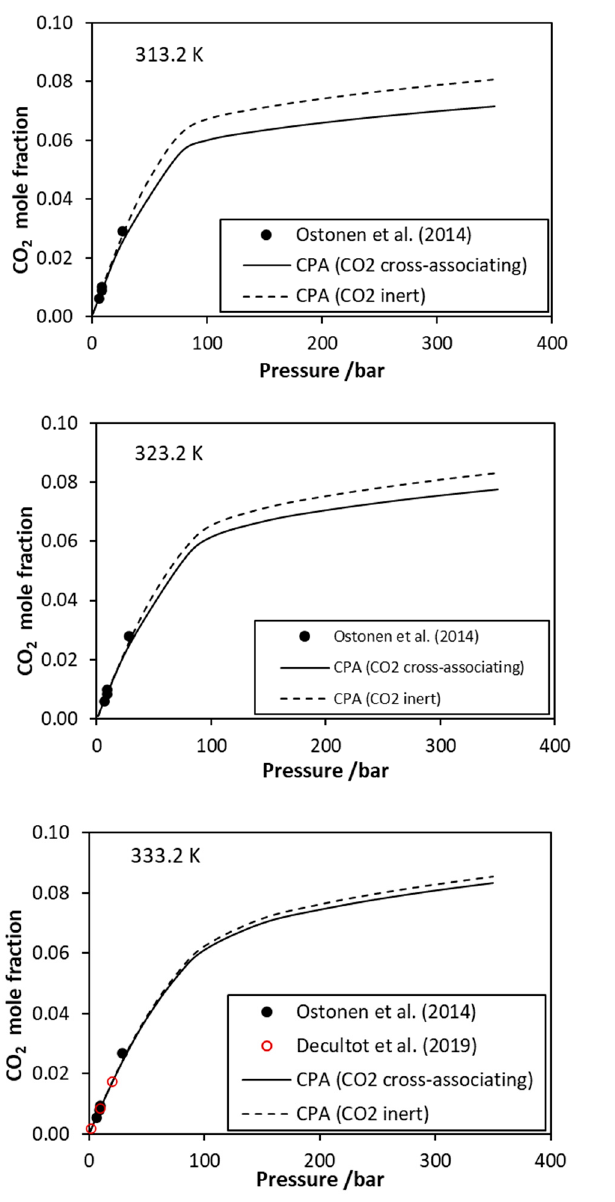
Figure 3. CO 2 –glycerol VLE. CO 2 mole fraction in the liquid phase and glycerol mole fraction in the vapor phase. Experimental data [39–42] and CPA correlations using the interaction parameters of Table 4.